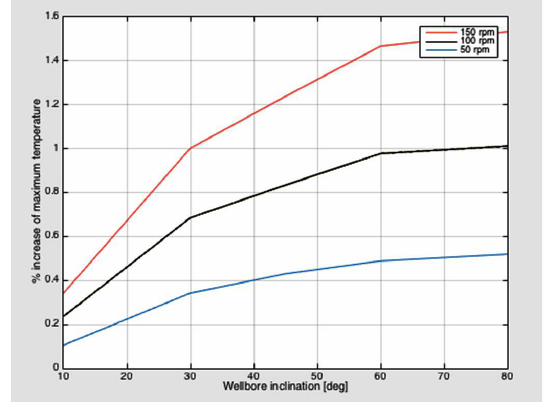
Figure 21: Increase in maximum temperature vs. inclination( µ = 0 .